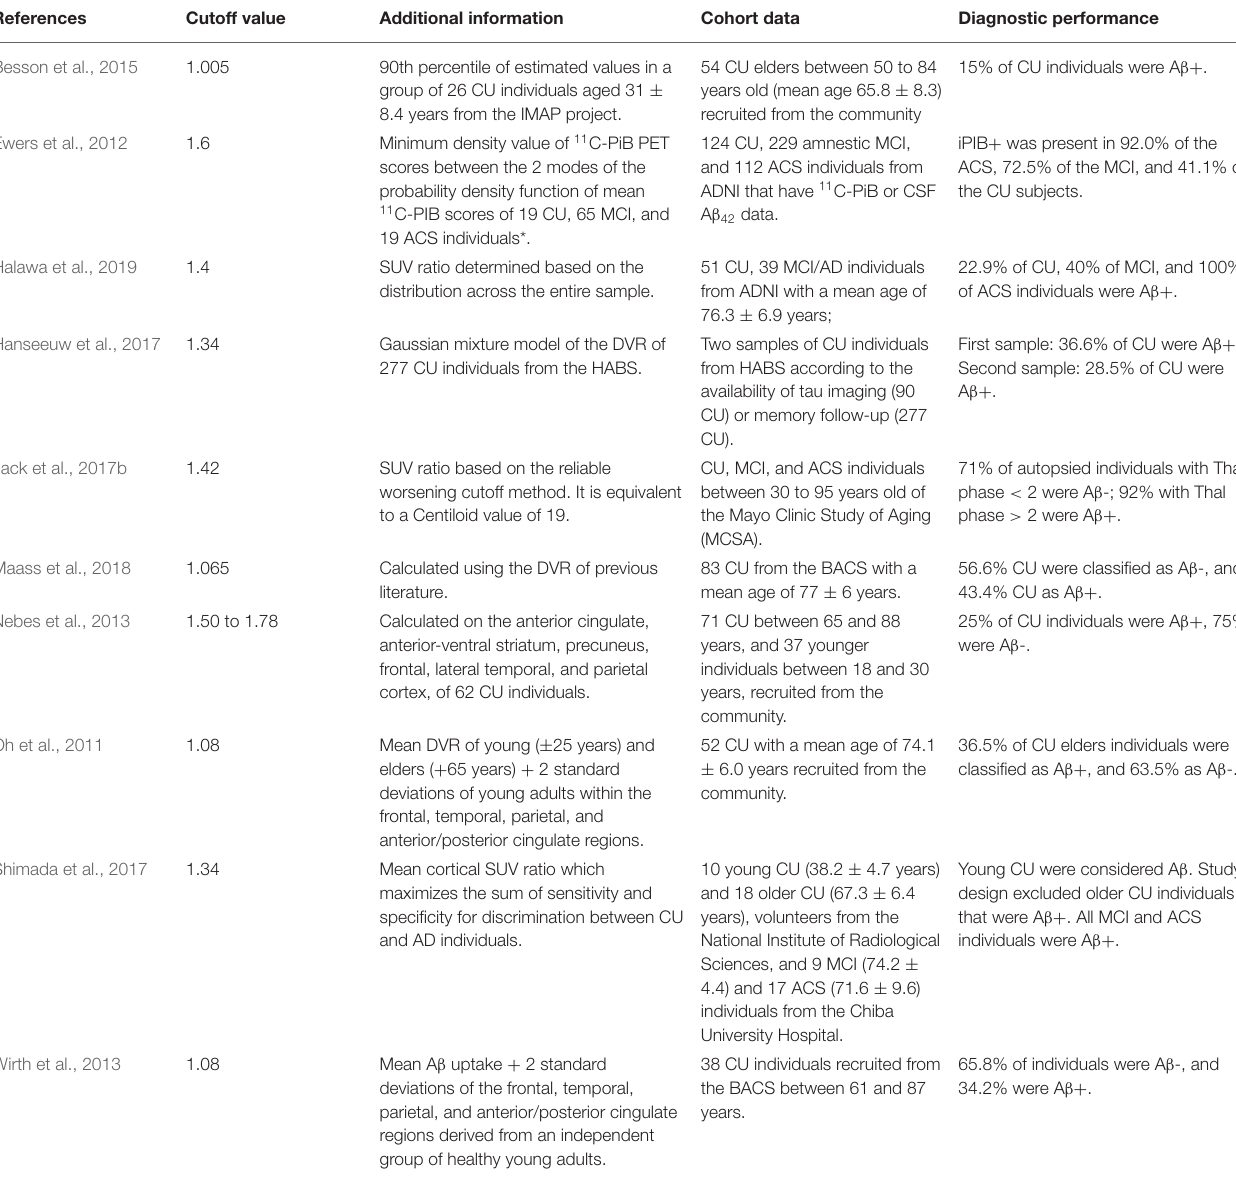
TABLE 1 | Cutoff values for A β tracers from the